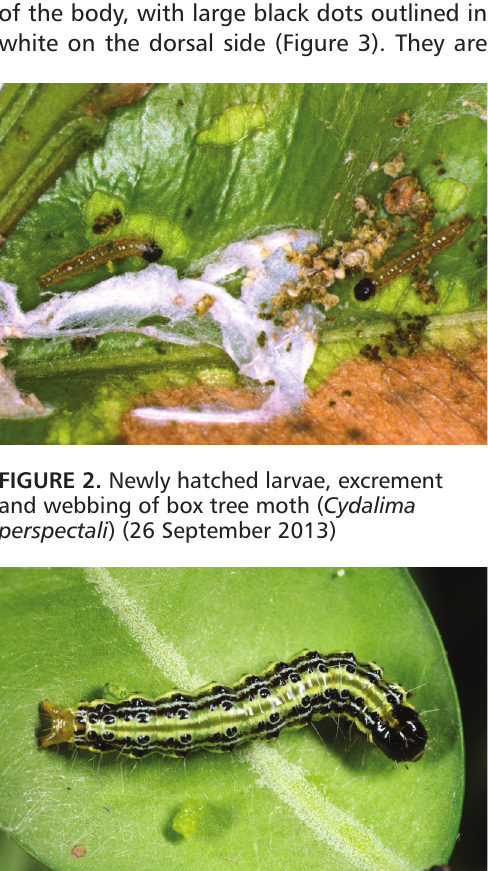
FIGURE 3. Mature larvae of box tree moth (photo György